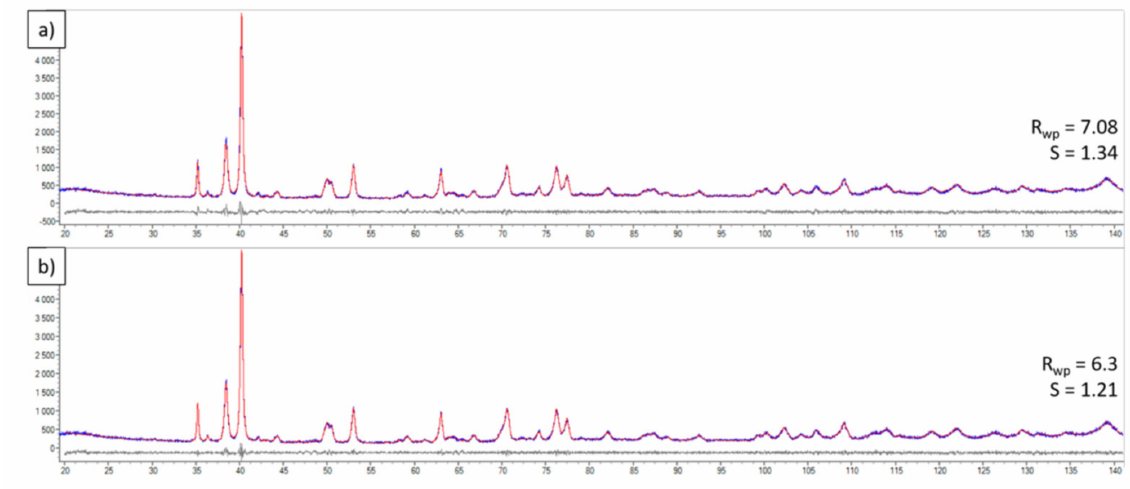
Figure 12. XRD patterns of Ti–2%TiC with differential curve calculated for ( a ) three-phase material ( α -Ti, TiO 2 , TiC) and ( b ) four-phase material ( α -Ti, TiO 2 , TiC and